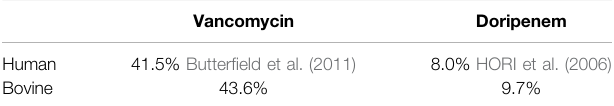
TABLE 3 | Comparison of plasma protein binding of vancomycin and doripenem between previously published values and binding ratesfound in bovineblood. Vancomycin